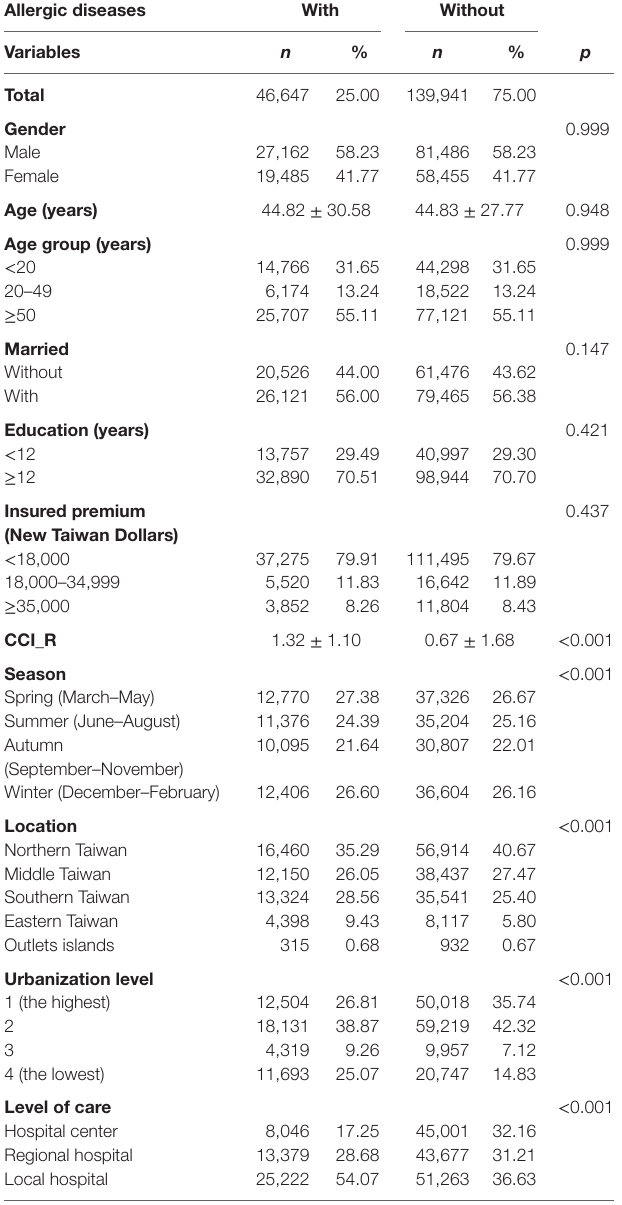
TaBle 1 | Characteristics of study at the baseline.